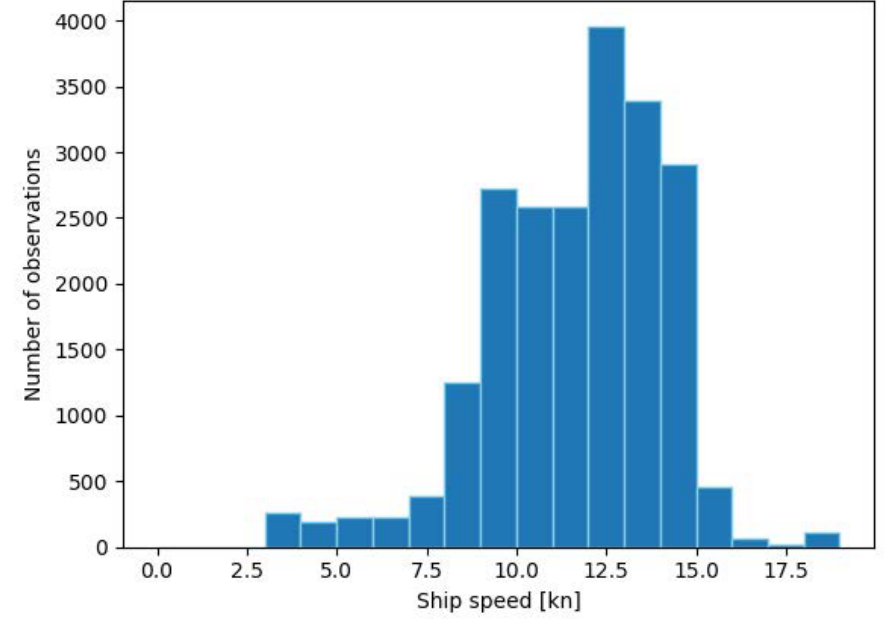
Figure 7. Yearly distribution of ship speed. Periods spent in port at 0 speed are excluded from the